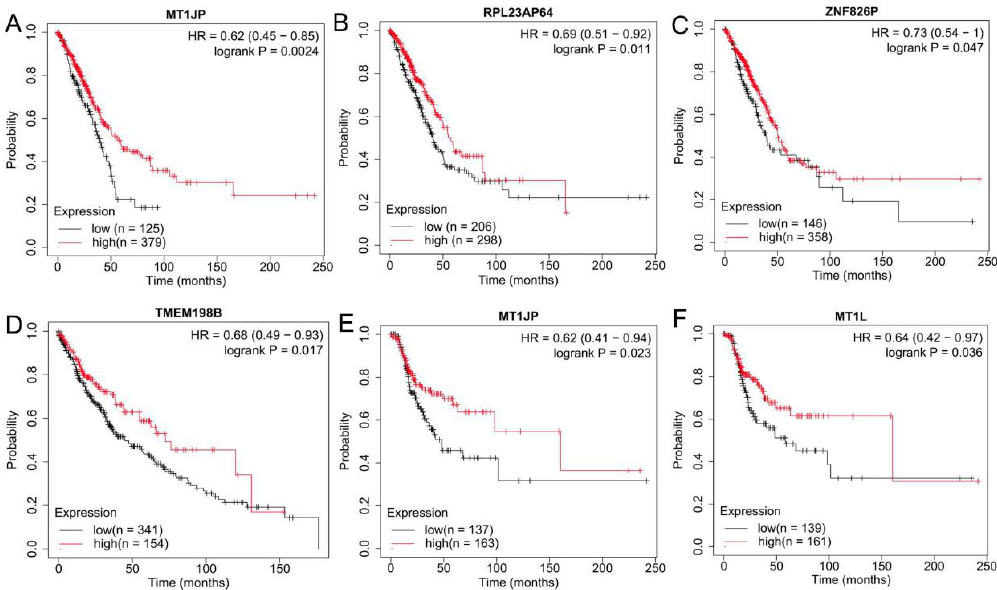
Figure 6. Validation of the prognosis of pseudogenes in lung cancer. ( A – C ) MT1JP ( A ), RPL23AP64 ( B ) and ZNF826P ( C ). Prediction for overall survival of LUAD patients by analysis of TCGA data; ( D ) TMEM198B. Prediction for overall survival of LUAD patients by analysis of TCGA data; ( E,F ) MT1JP ( E ) and MT1L ( F ). Prediction for recurrence-free survival of LUSC patients by analysis of TCGA data. HR, hazard ratio; LUAD, lung adenocarcinoma; LUSC, lung squamous cell carcinoma; TCGA, the Cancer Genome Atlas. Table 1. The expression levels of crucial genes.